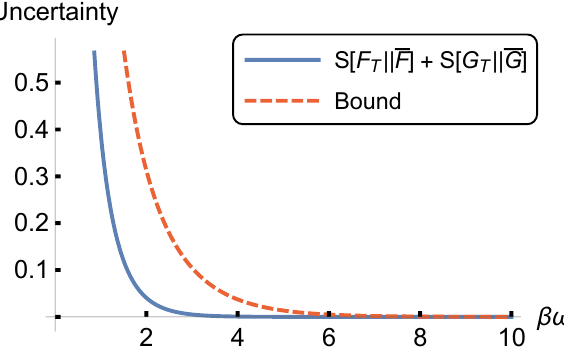
Figure 1: Both sides of (66) are shown as a function of β for one mode with fixed frequency ω . For large β , the thermal state ρ the bound becomes tight. For small β , the state ρ uncertainty grows. For β → 0 the state approaches the uniform distribution in which case the entropic uncertainty is